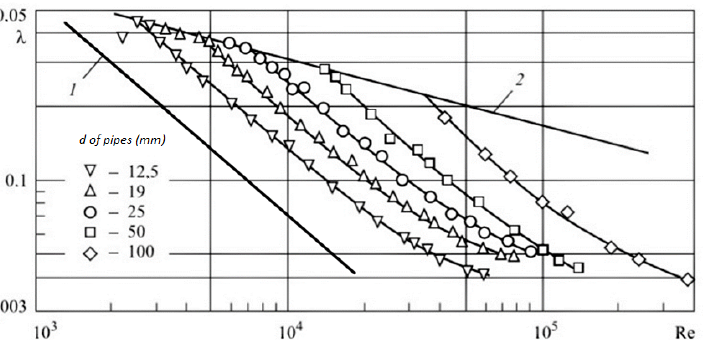
Figure 2. Change in resistance coefficients depending on the Reynolds number and pipe diameter at a constant concentration of WSR-301 (from [4]) polymer solution: 1—laminar flow; 2—turbulent